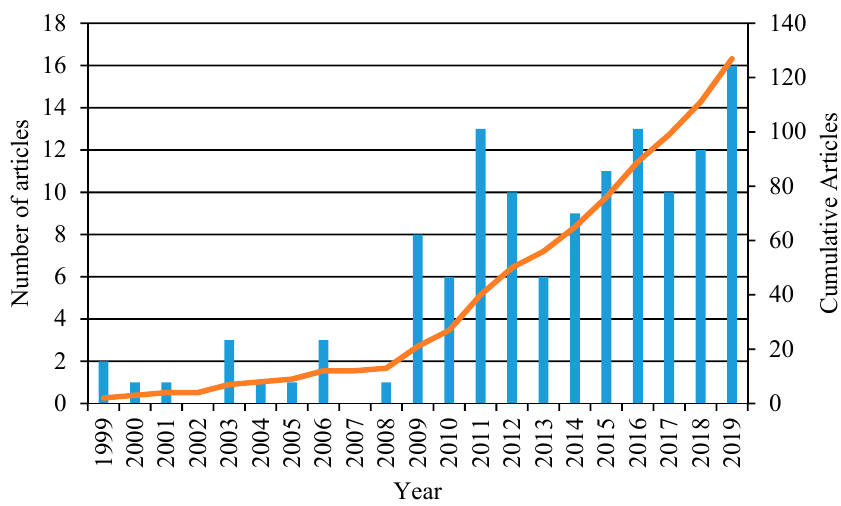
Figure 1. Analysis of the literature database from 1999–November 2019. The left Y axis represents the number of articles per year and the right Y axis depicts the cumulative number of articles for the entire period.